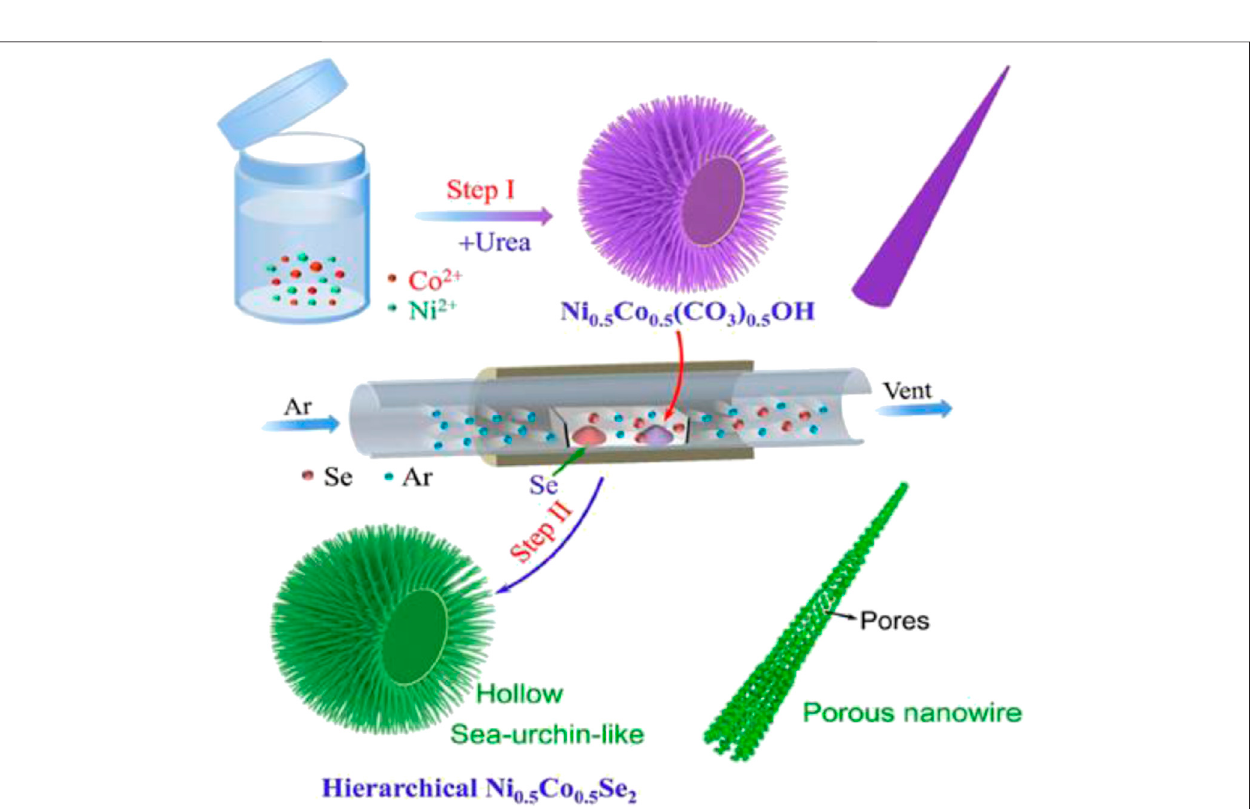
FIGURE 12 | Hierarchical hollow, sea-urchin-like and porous Ni 0.5 Co 0.5 Se 2 as advanced battery.